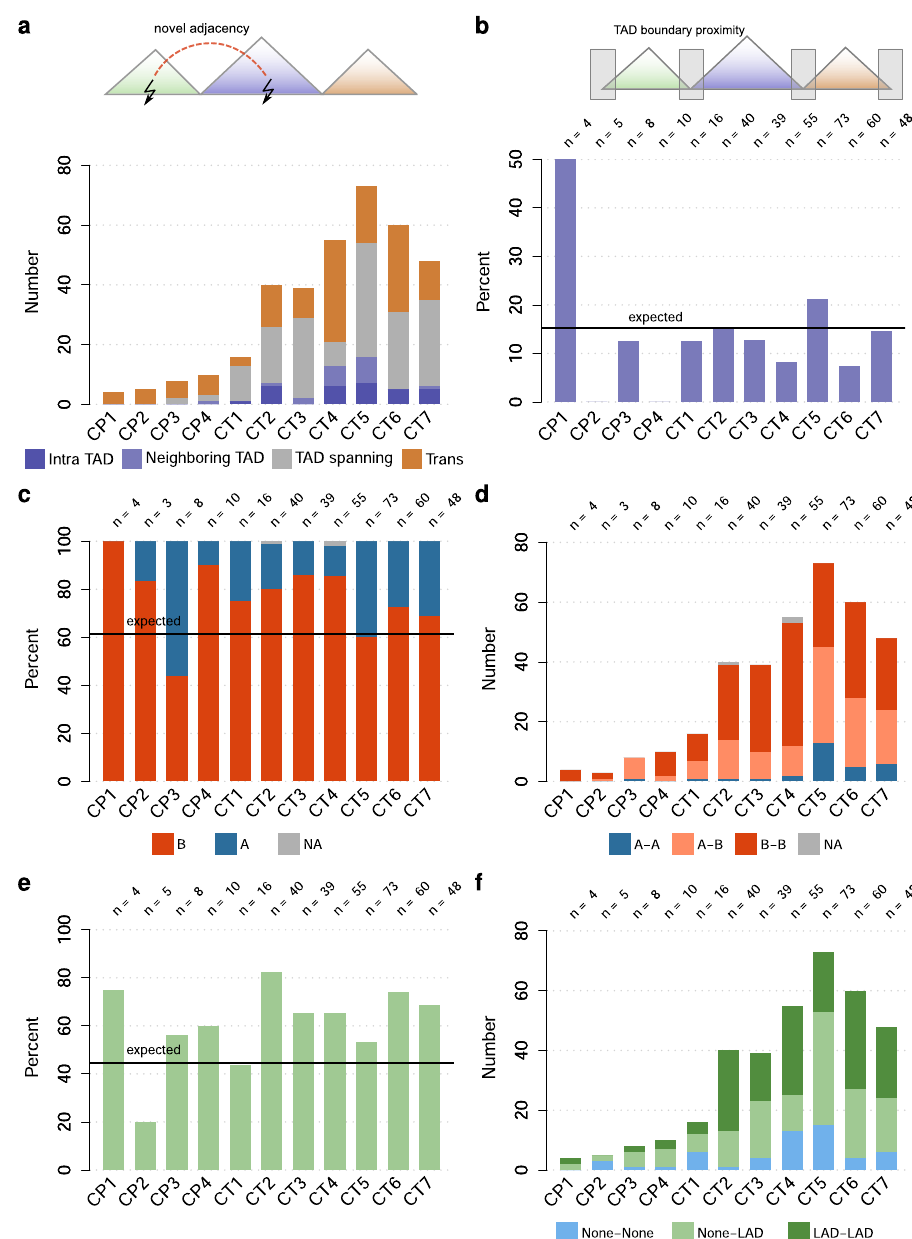
Fig.3|Analysisofthe3Dchromatinstructurearoundbreakpoints. Forselected genomic features, a horizontal line indicates the expected value, which is derived from the genome-wide fraction of the corresponding feature. a Number of novel adjacencies with breakpoints located in the same TAD, in neighboring TADs, span- ning at least one TAD and on different chromosomes, respectively. b Percentage of breakpoints locating in TAD boundaryregions (±50kb).The black line indicates the